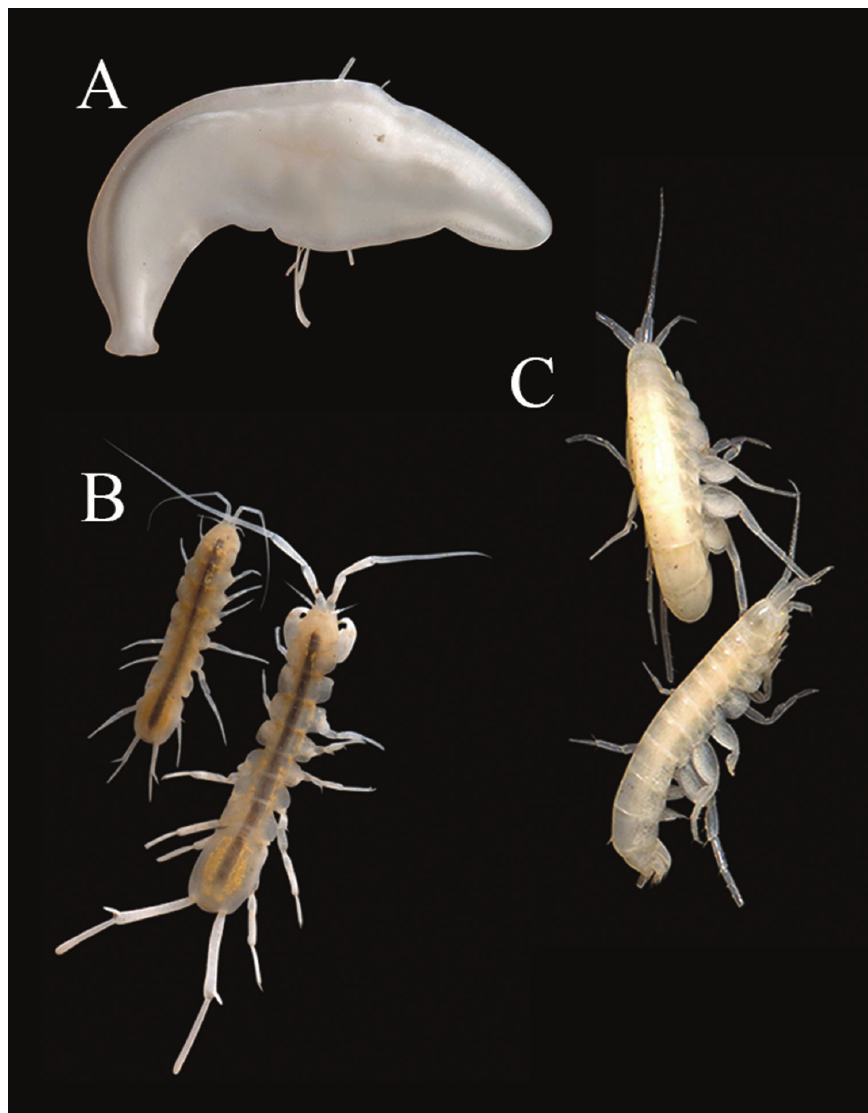
Figure 3. A Sphalloplana mohri Hyman, 1938 from Cold Spring, Travis Co., Texas, USA B Caecidotea reddelli (Steeves, 1968) from Rocket River Cave, Coryell Co., Texas, USA C Stygobromus balconis (Hu- bricht, 1943) from Autumn Woods Well, Hays Co., Texas, USA. All photographs by Dr. Jean K. Krejca, Zara Environmental LLC. Images not to